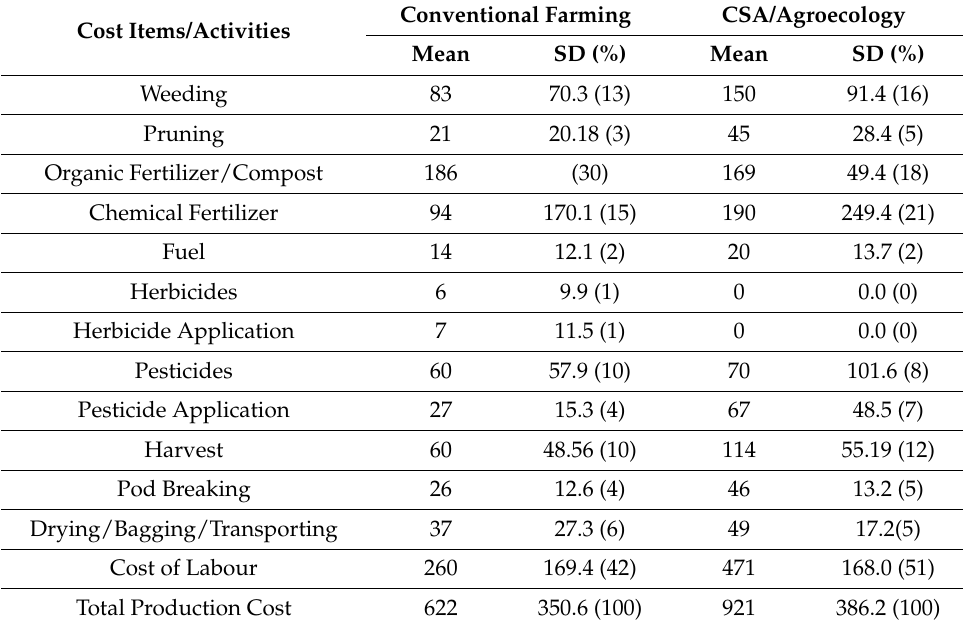
Table 5. Share of Average Cocoa Production Costs in Ghana Cedis per Hectare